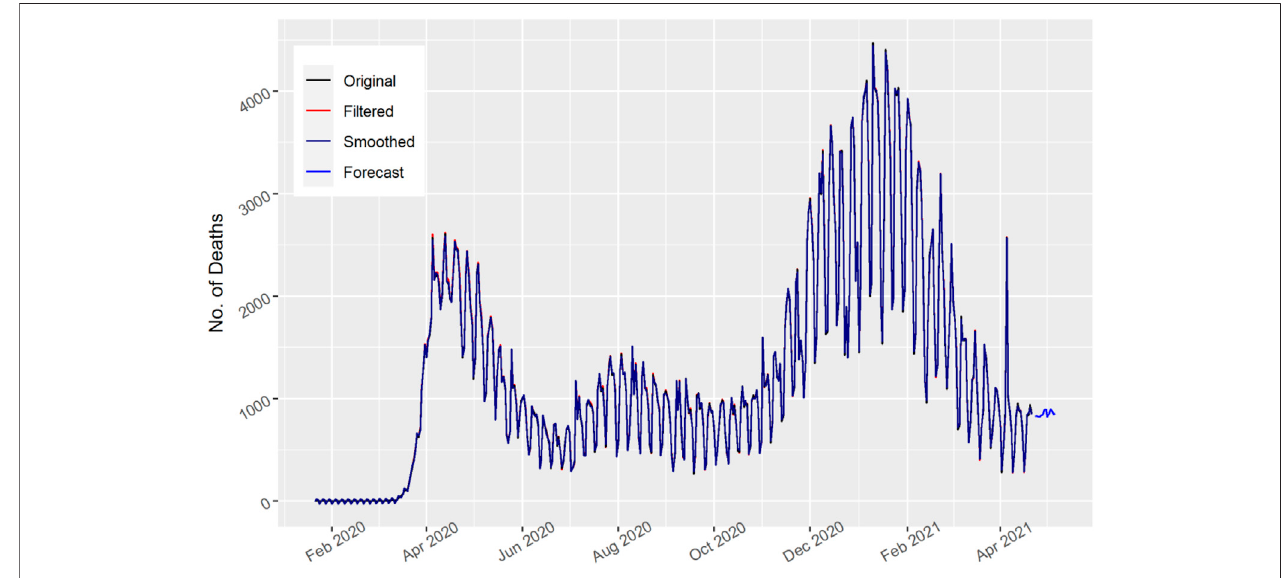
FIGURE 5 | Number of daily death cases in the United States.